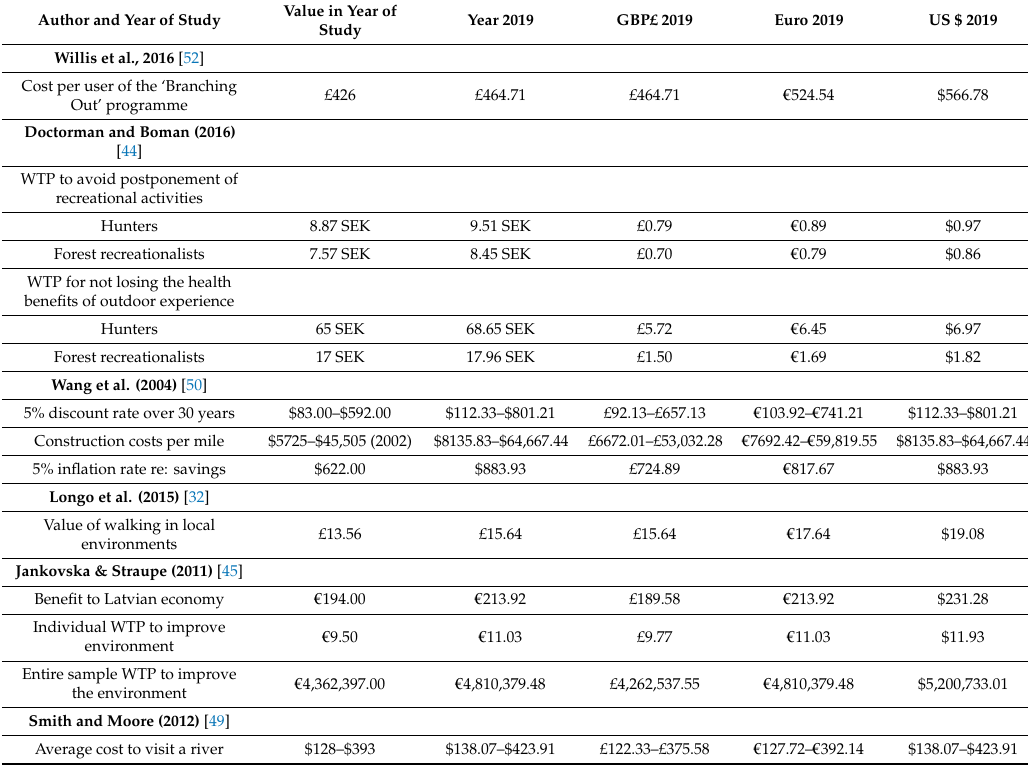
Table 2. Monetary valuations for green and blue spaces. WTP: willingness to